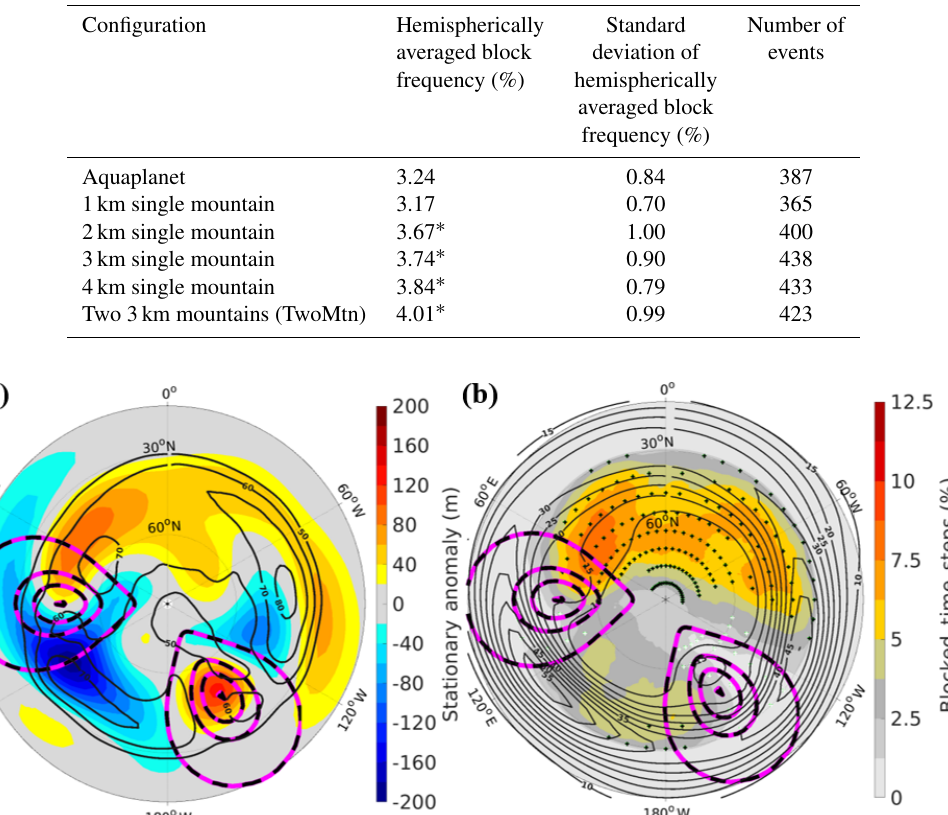
Figure 7. For the two-mountain idealized model integration, (a) the cool-season stationary wave (shading) and storm track (heavy black contours) and (b) the cool-season blocking climatology (shading) and U 250 (heavy black contours) are shown. In (a) storm track contours are in 10m intervals where the outer contour is 50m. In (b) U 250 contours are in 5ms − 1 intervals where the outer contour is 10ms − 1 . Black (white) stippling in (b) indicates significantly greater (lower) block frequency at nearby grid points when compared to a 250-year aquaplanet integration. Dotted pink and black contours represent surface height, where the outer contour is the edge of the land mask and the inner contours are in 1km